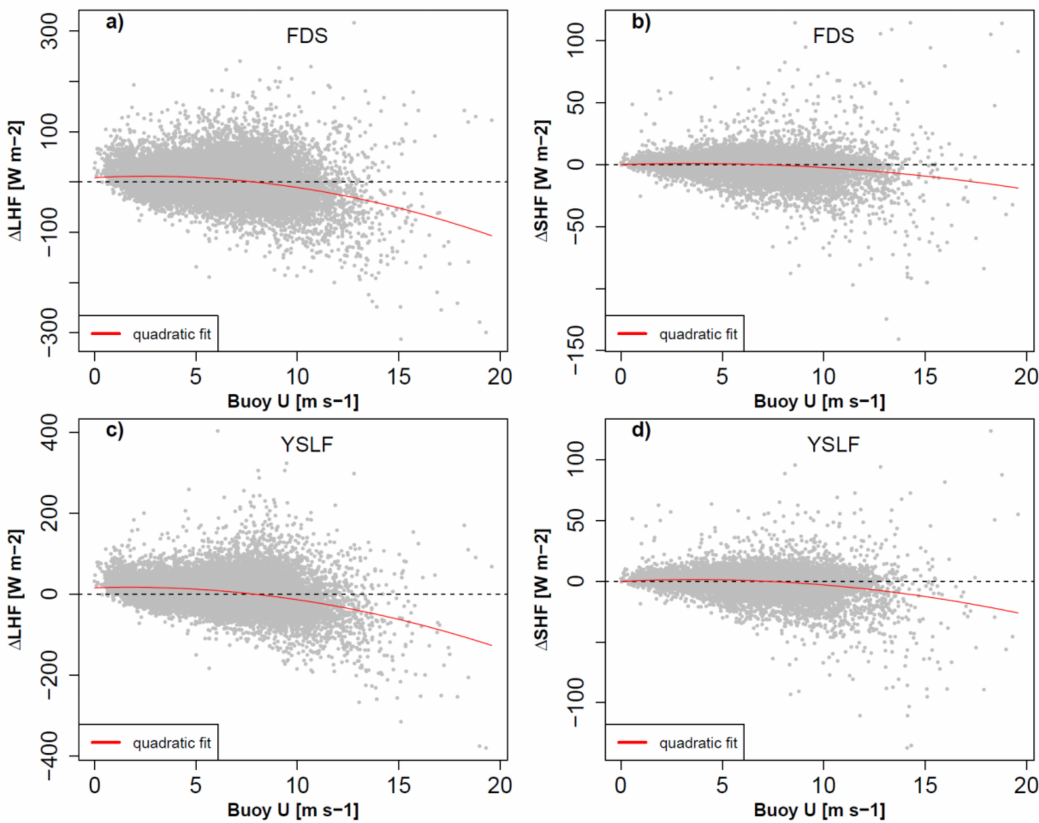
Figure 8. Di ff erences in fluxes (CYGNSS-Buoy) and how they vary with increasing wind speed observations from the buoy data. This is done for LHF ( a , c ) and SHF ( b , d ) and their respective FDS ( a , b ) and YSLF ( c , d )